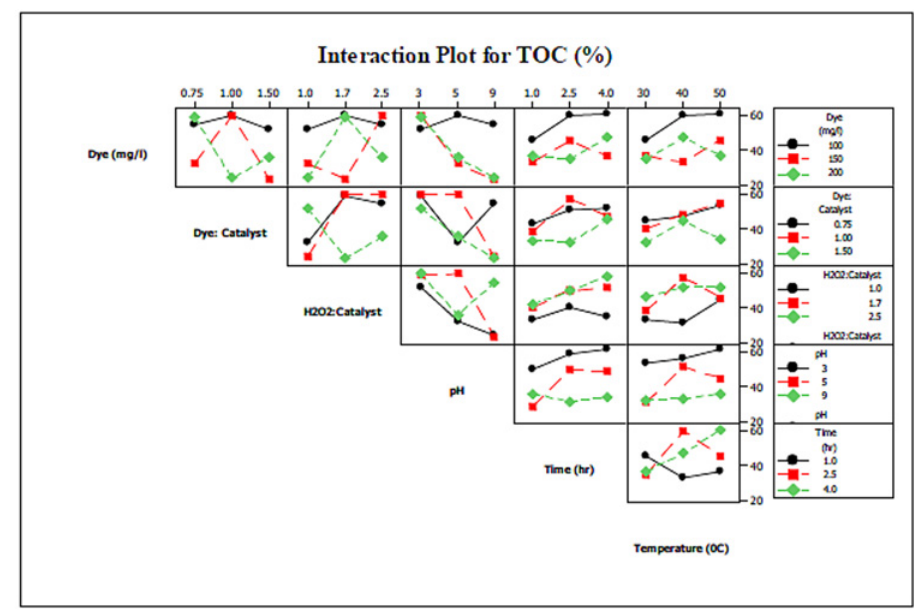
Fig 5. Interaction of parameters with respect to